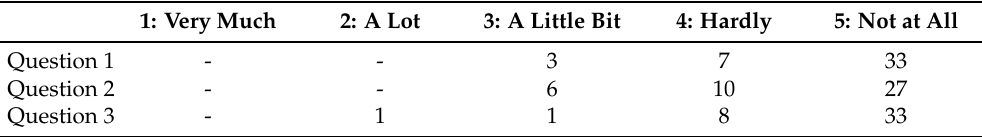
Table A1. Results of the questionnaire on the perceived obtrusiveness of the remote PPG setup, totals per answer option.